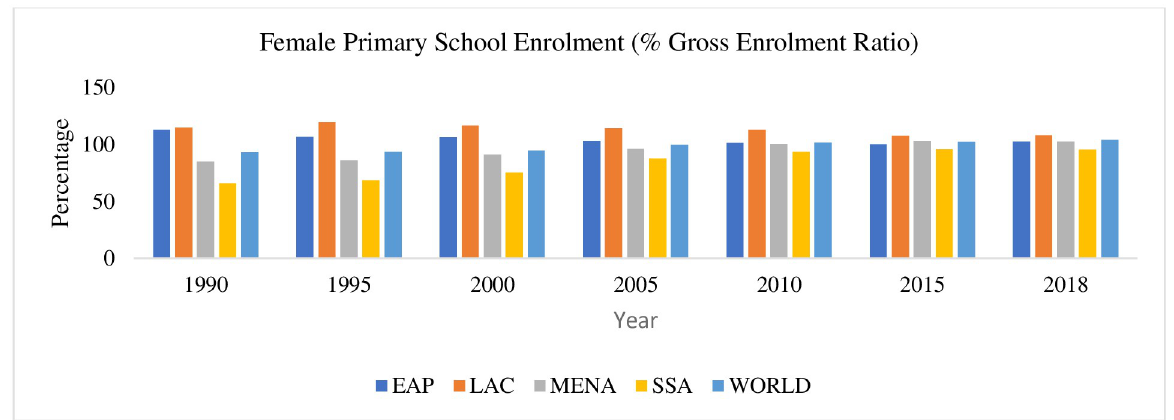
Fig 2. Female primary school enrolment (percentage of gross enrolment ratio). Source: Researchers’ Compilation, using World Bank (2019) data.